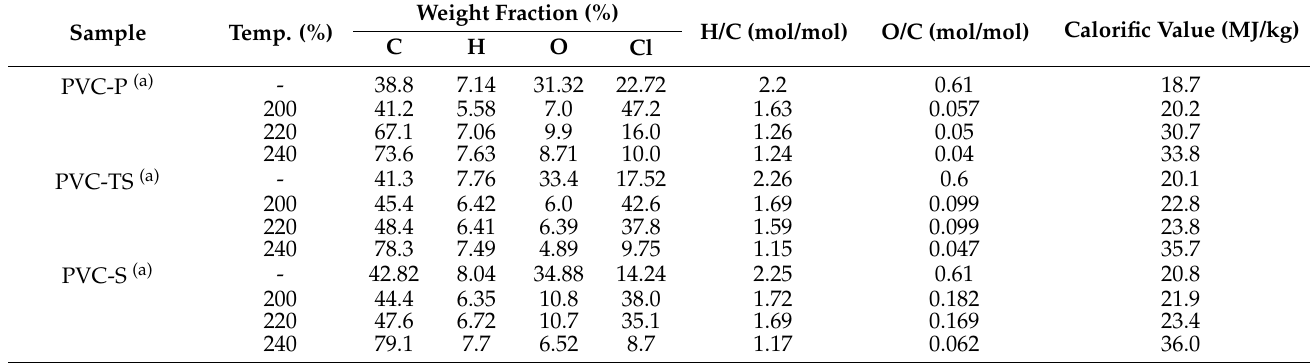
Table 5. Comparison of elemental analysis and calorific value. (a) Calculated value for mixture